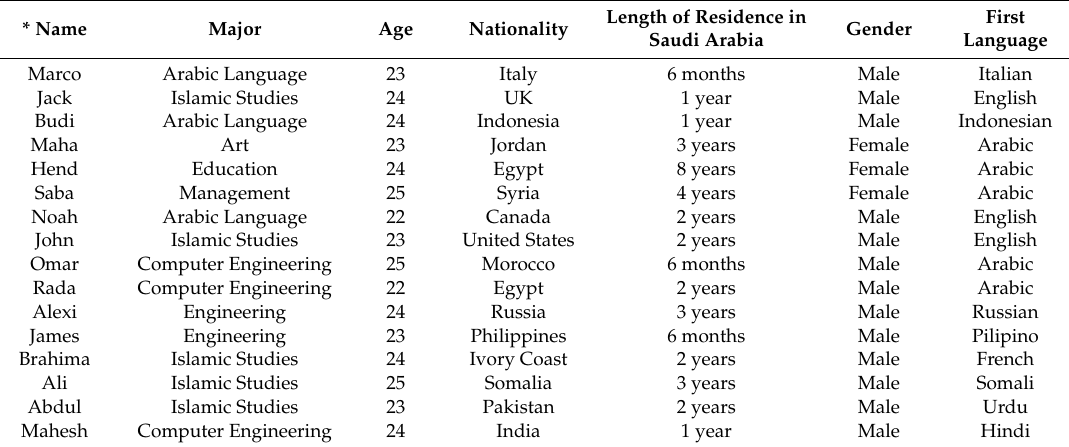
Table 1. Respondent profile (students).